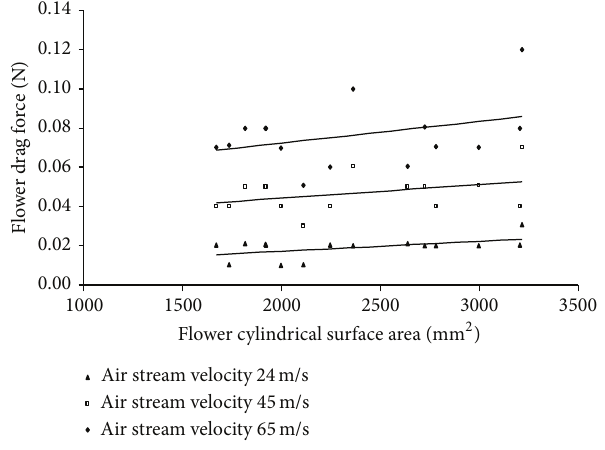
Figure 8: Variation in flower drag force with “cylindrical surface area of the flower” for three mean air stream velocities (crop sample Hidcote).